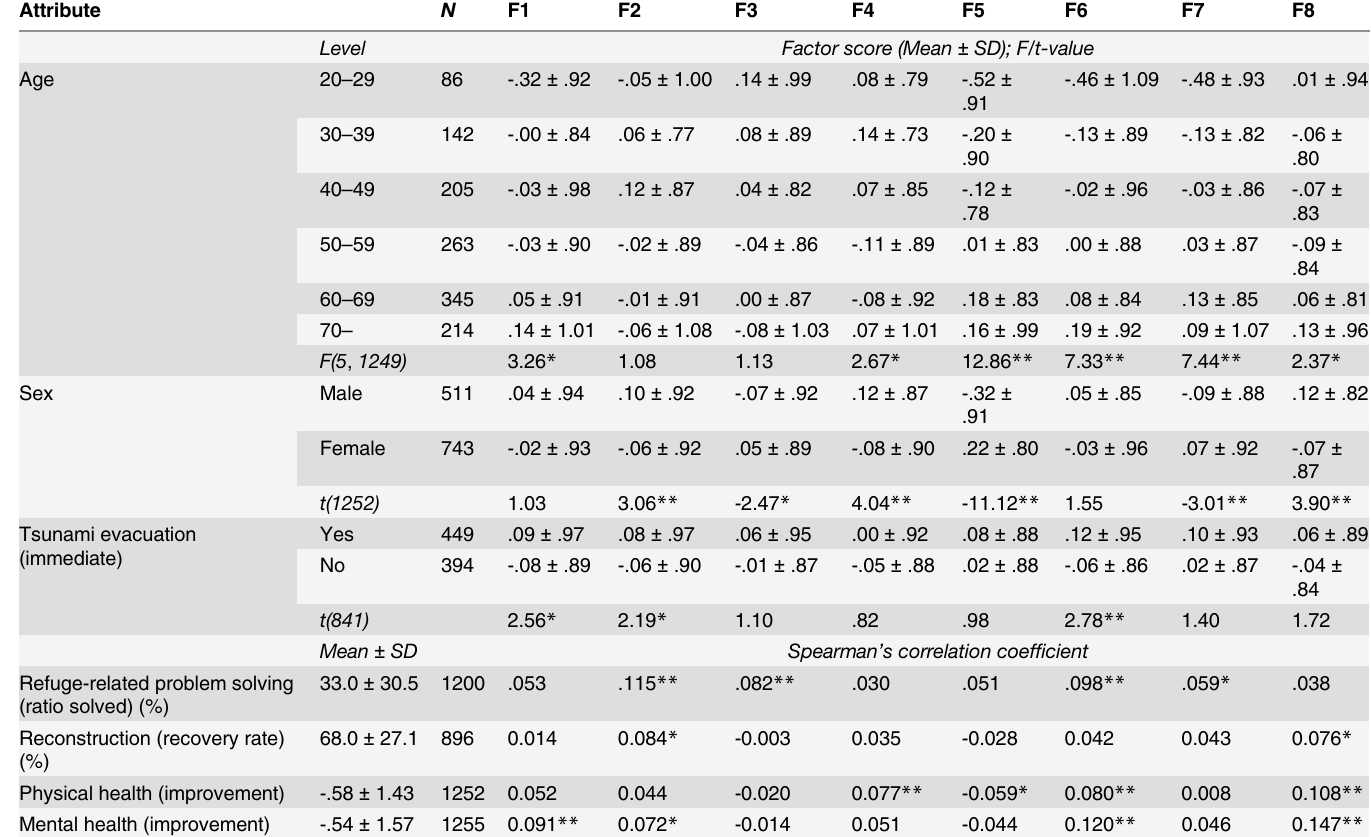
Table 3. Relationships of factor scores to age, sex, and survival success.